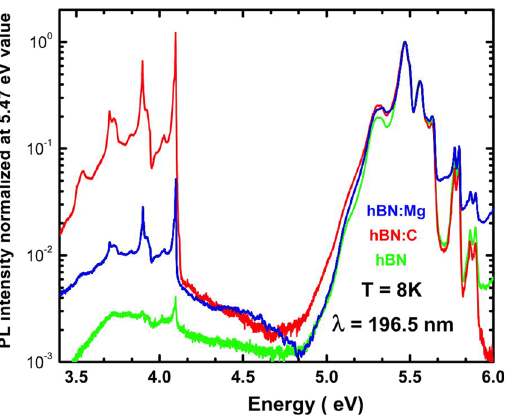
Figure 16: Low temperature photoluminescence spectra of different hBN crystals: undoped hBN from hqgraphene (green); grown under Mg-rich ambient (blue plot, figure 1 of reference [31]) and under moderately C-rich ambient (red plot, spectrum C20 in fi gure 1 of reference